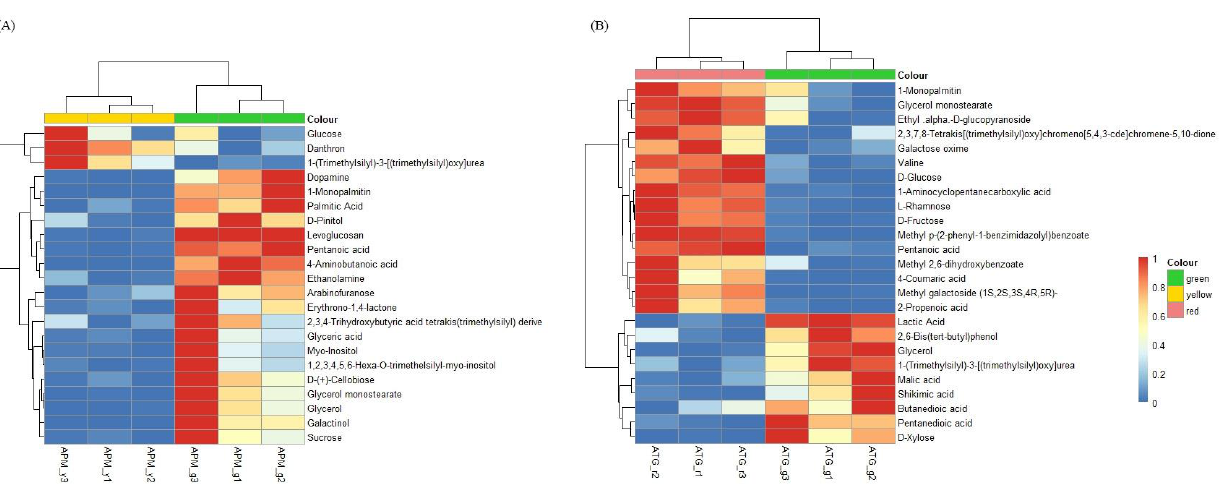
Figure 6. Cluster analysis of differential metabolites in leaves during different seasons: ( A ) APM and ( B ) ATG. Three biological replicates per group; blue indicates low compound accumulation, while red indicates high compound accumulation.